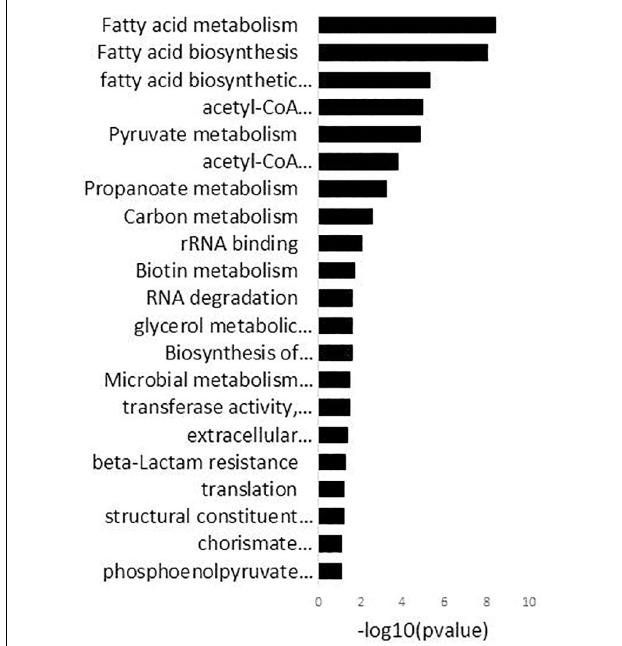
FIGURE 2 | DAVID analysis of functional gene ontology (GO) categories and KEGG pathways related to the genes differentially expressed in 15 mM oleuropein. Fold enrichment (bars) parameter measures the magnitude of enrichment, both for up and down-regulated gene groups.